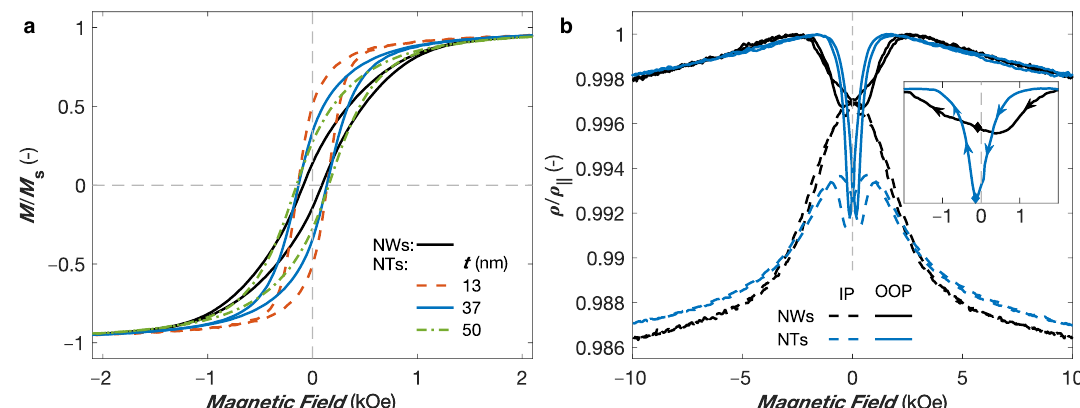
Figure 7. ( a ) Hysteresis loops measured with the magnetic field applied along the out-of-plane (OOP) direction of Ni crossed nanotube networks with 230 nm in diameter and 20% of packing fraction for different wall thicknesses, compared to the hysteresis loop for a Ni crossed nanowire network with similar diameter and packing density characteristics. ( b ) Comparison of the anisotropic magnetoresistance curves measured with the external field applied in the OOP (continuous lines) and in-plane (IP, dashed lines) directions of the crossed NT network with wall thickness of ∼ 37 nm, and crossed NW networks, both with diameter of 230 nm and packing fraction of about 20%. The inset in panel ( b ) show a zoom at low fields of the OOP AMR curves when sweeping the magnetic field from positive to negative, as indicated by the arrows. The lozenges indicate the resistance states at the corresponding coercive field for each